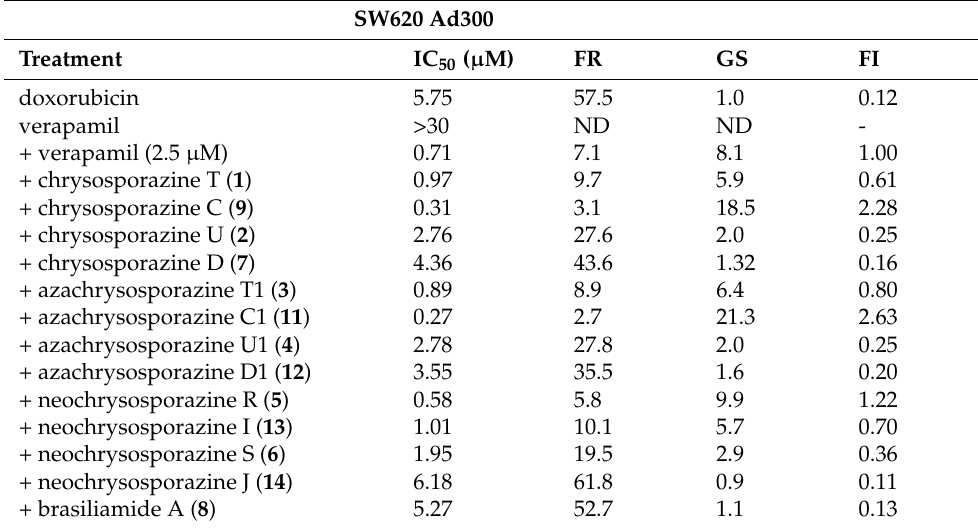
Table 3. Ability of analytes 1 – 9 and 11 – 14 to reverse doxorubicin resistance in P-gp over-expressing human colorectal carcinoma cells (SW600 Ad300).